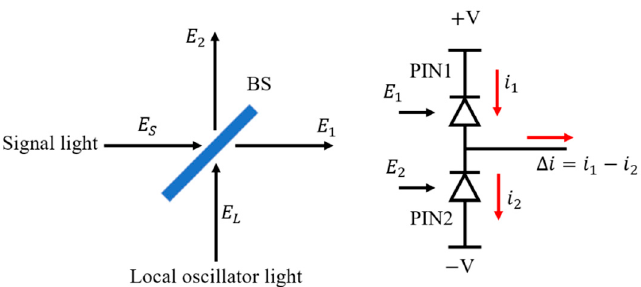
Figure 1. Balance detection.